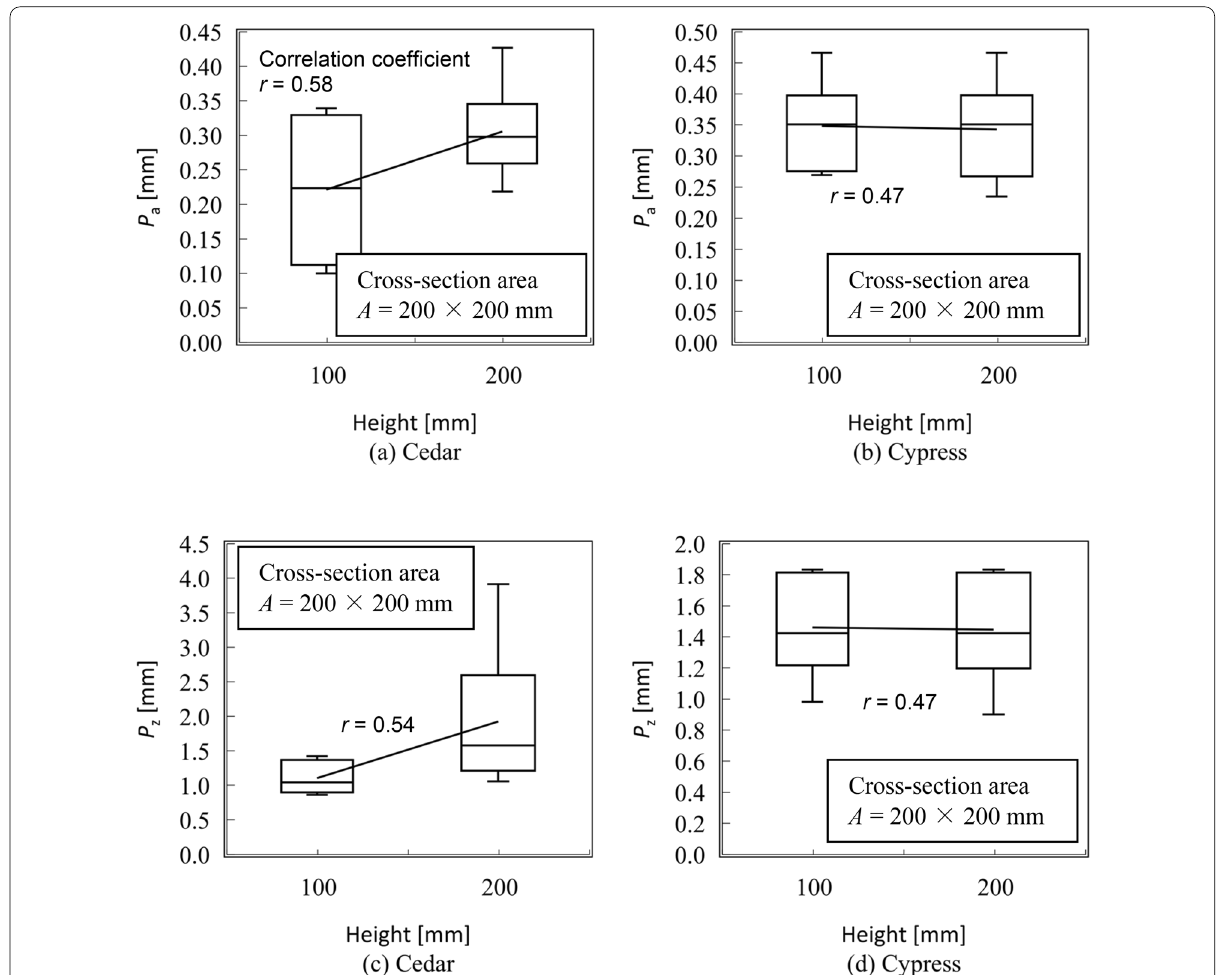
Fig. 16 Relationship between the profile parameters and the height of the